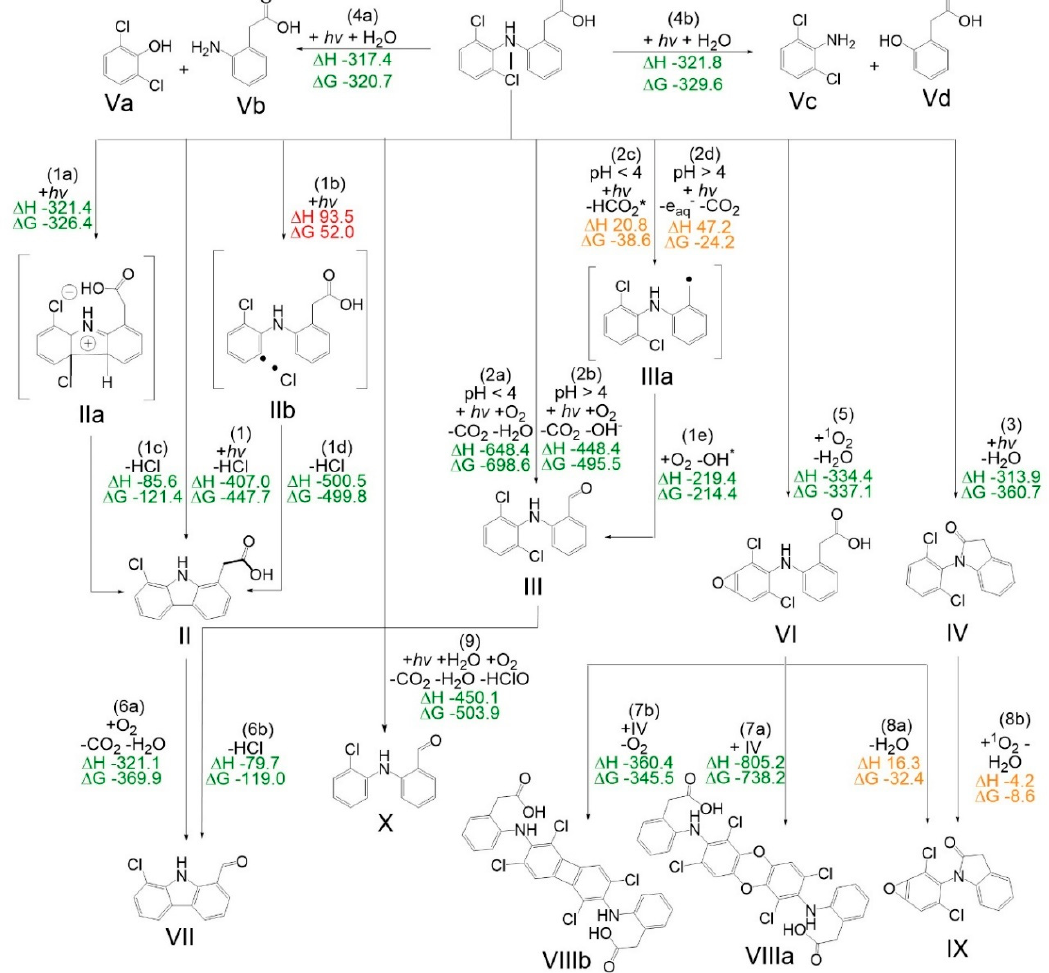
Figure 2. Suggested reaction pathway of the irradiation of diclofenac with UVA light with added reaction enthalpies ( Δ H) and the Gibbs free energy of the reactions ( Δ G) as calculated by DFT. The reaction energies are colored corresponding to their probability of occurring under the given reaction conditions. Green reactions show a high likelihood, orange reactions can take place and red reactions are not feasible within the given conditions.